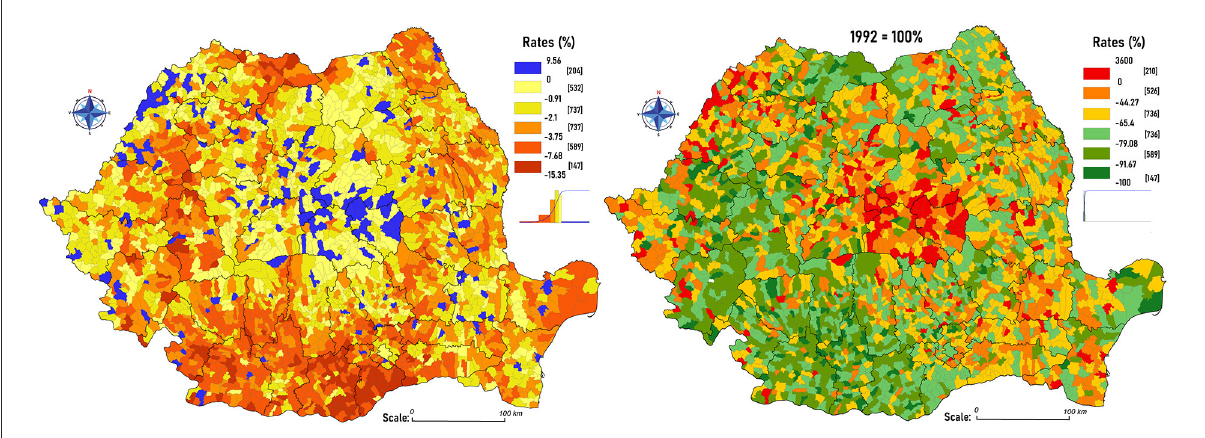
FIGURE4 (A) The percentage evolution in the share of illiterates between 2011 and 1992 and (B) The percentage differences in the number of illiterates between 2011 and